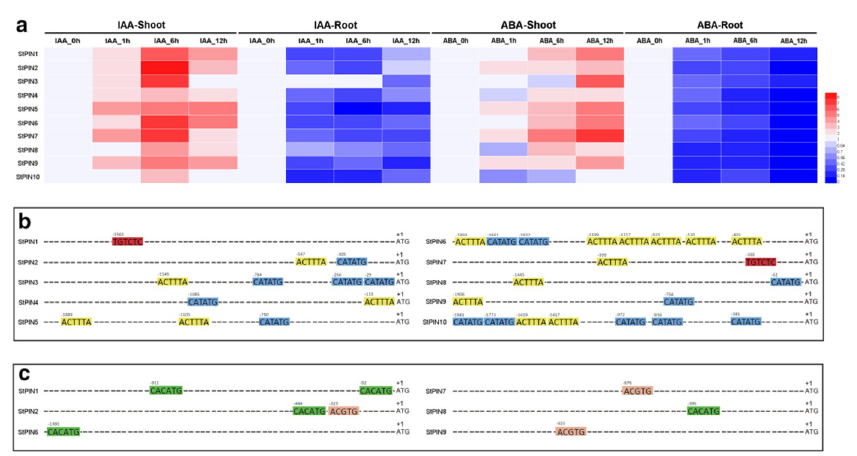
Figure 5. Quantitative RT-PCR analysis of StPINs from roots and shoots of potato plantlets treated with IAA and ABA. ( a ) Expression of StPIN genes after auxin and abscisic acid treatments. Data represented the means of three biological and two technical replicates in qRT-PCR analysis. The relative expression level was calculated by 2 - ∆ ∆ CT method comparing with internal standard (reference gene ef1 α ) and control, respectively, which was normalized to a value of 1 (Table S3). ( b ) Analysis of StPINs with putative auxin responsive elements present in their promoter regions. The elements included auxin response factor (ARF)-binding site (S000270), tissue-specific expression and auxin-inducible (S000273) and auxin-inducible (S000370) marked with red, yellow and blue rectangle, respectively. ( c ) Analysis of StPINs with putative ABA responsive elements present in their promoter regions. The elements included ABA responsive element (S000414) and ABA-inducible (S000174) marked differently with pink and green rectangles.